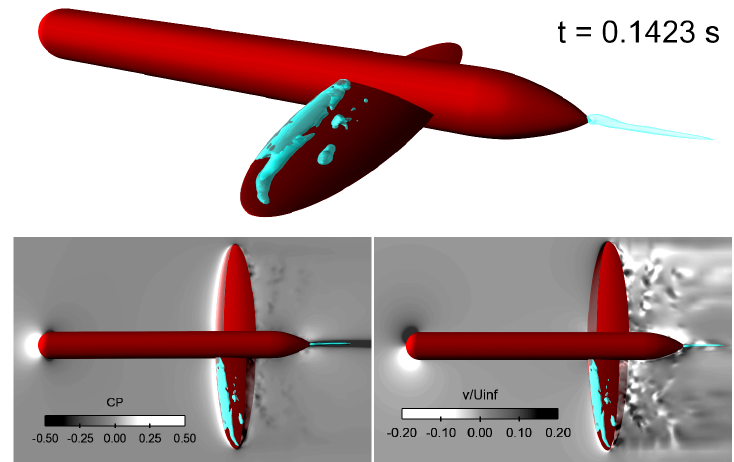
Figure 9. A snapshot of the simulations with U ∞ = 8 m/s and σ = 1.27. Fine grid DDES. Top frame presents an overview of the cavity extent with the transparent iso-surface of α = 0.1 colored by blue. Lower left frame shows the pressure coefficient on the center z plane of the cavitator. Lower right frame shows the non-dimensional v -velocity on the center z plane of the cavitator.